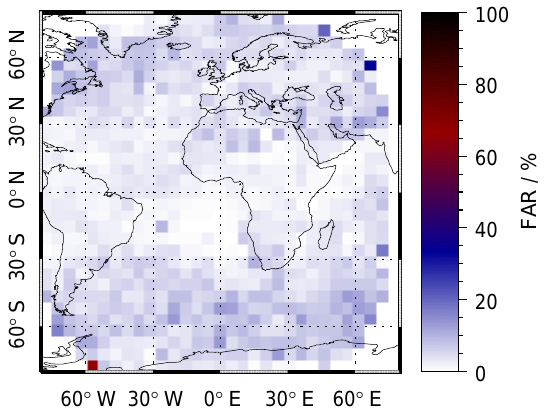
Figure 8. FAR of the CiPS OPF (opacity